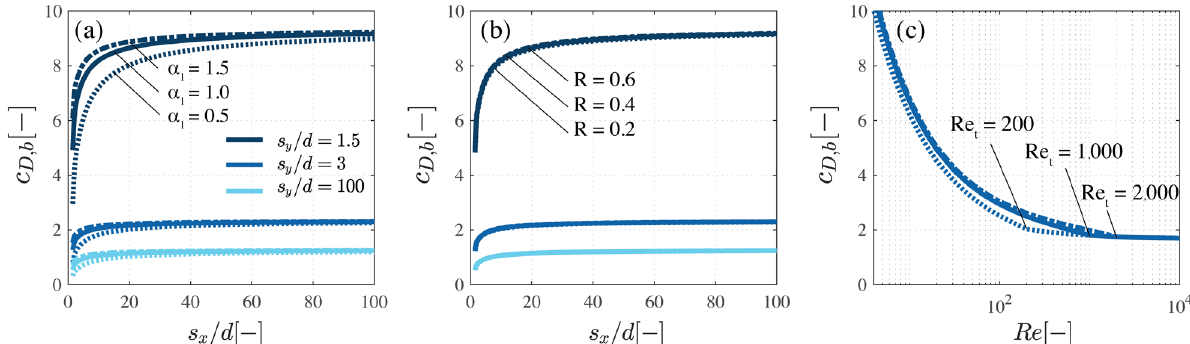
Figure 5. Sensitivity of the modelled bulk drag coefficient c D , b to varying values of ( a ) the scale factor α 1 and ( b ) the correlation factor R , as a function of the streamwise spacing s x and spanwise spacing s y between cylinders compared to the cylinder diameter, d . Plot ( c ) shows the influence of the limit for turbulent flow, Re t , on the bulk 1.5 as a function of the Reynolds number Re drag predictions for s y / d =